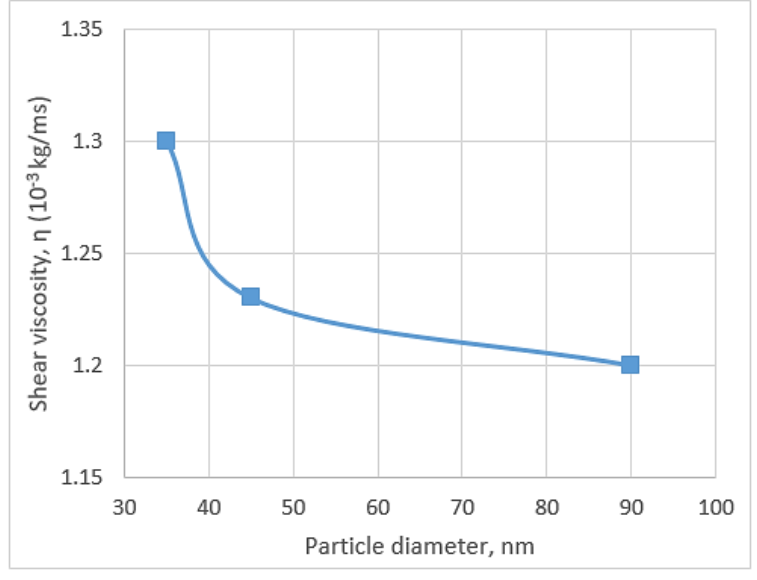
Figure 8. Shear viscosity’s decreasing trend with particle size. [87]